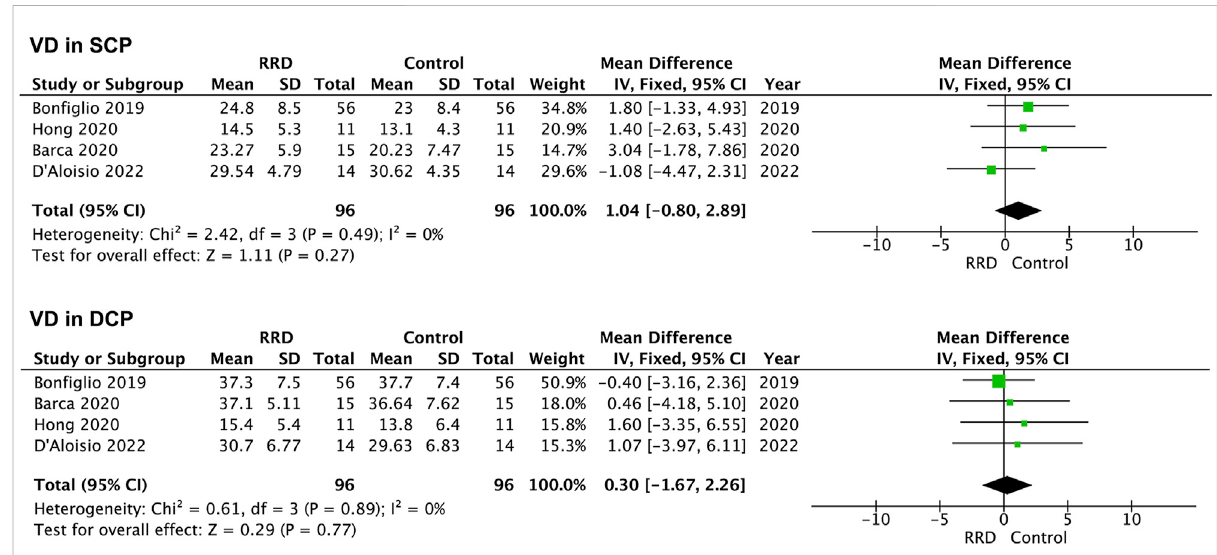
FIGURE 4 Forest plots of changes in foveal VD in eyes with Macula-on RRD. VD, vascular density, SCP, super fi cial capillary plexus; DCP, deep capillary plexus, RRD, rhegmatogenous retinal detachment.